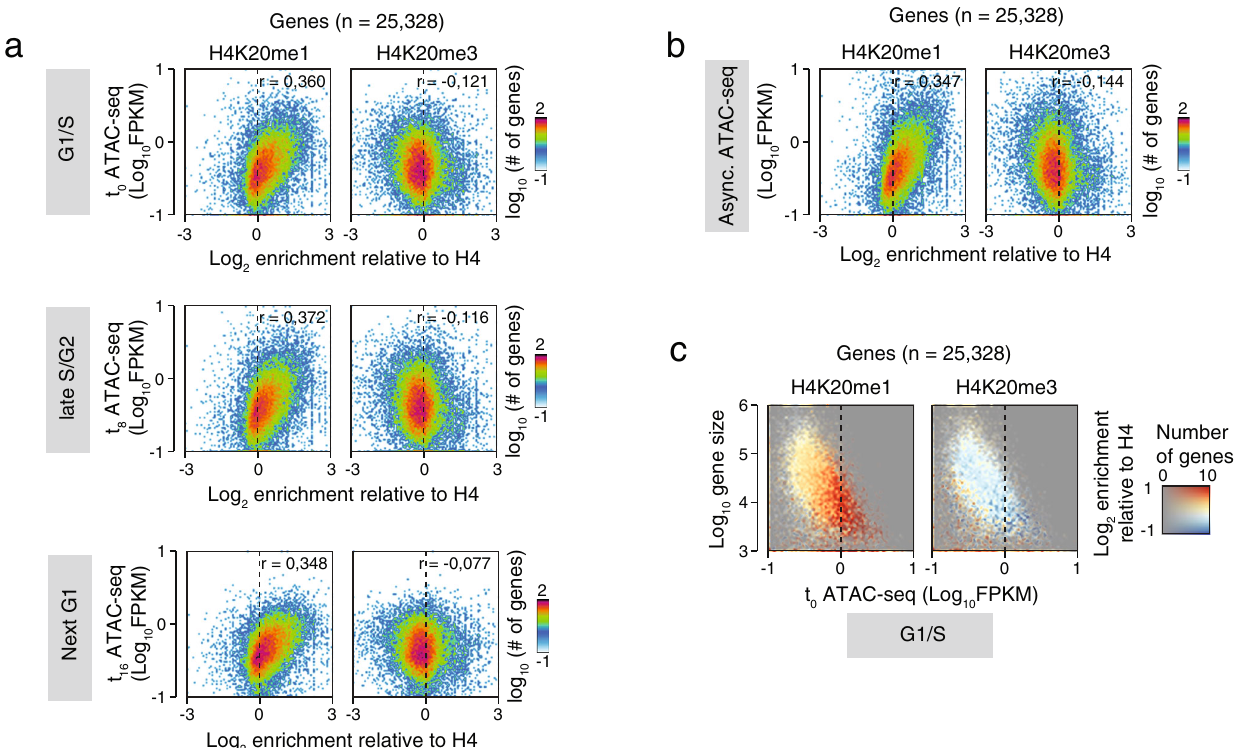
Fig. 1 Chromatin accessibility at genes bodies correlates with histone H4 lysine 20 mono-methylation throughout the cell cycle. a 2D-histograms showing the relationship between enrichment of selected H4K20 methylation states ( X -axis) and chromatin accessibility probed using ATAC-seq ( Y -axis) at human genes. X -axis shows log2 normalized H4K20me1 (left side) or H4K20me3 (right side) ChIP-seq levels relative to the levels of H4 control ChIP- seq, while Y -axis shows log10-transformed average FPKM-normalized ATAC-seq signal from synchronized U2OS cells at different cell cycle phases, i.e., G1/S (0 h — top, three replicates), S-G2 (8 h — middle, three replicates) and next G1 phase (16 h — bottom, four replicates). The color scales re fl ect the number of genes having a certain combination of H4K20me enrichment and ATAC-seq. r -values show the Pearson ’ s correlation coef fi cients for the data in each plot. b 2D-histograms showing the relationship between enrichment of selected H4K20 methylation states ( X -axis) and chromatin accessibility probed using ATAC-seq ( Y -axis) at human genes as in a . Y -axis shows log10-transformed average FPKM-normalized ATAC-seq signal from four replicates of U2OS cells grown asynchronously. c Colored 2D-histograms showing the three-way relationship between enrichment of selected H4K20 methylation states (color), ATAC-seq signal ( X -axis), and gene sizes ( Y -axis) at human genes. Coloring shows log2 normalized H4K20me1 (left side) or H4K20me3 (right side) ChIP-seq levels relative to the levels of H4 control ChIP-seq with the number of genes with a certain combination of ATAC-seq signal and size controlling opacity as indicated in the right side color scale. X -axis show log10-transformed average FPKM-normalized ATAC-seq signal from three replicates of synchronized U2OS cells 0 h after